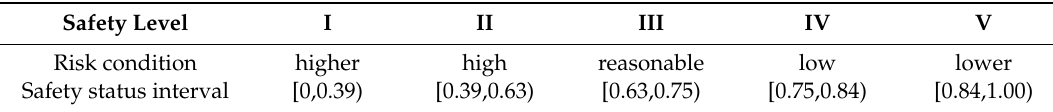
Table 7. Membership function for the safety level.